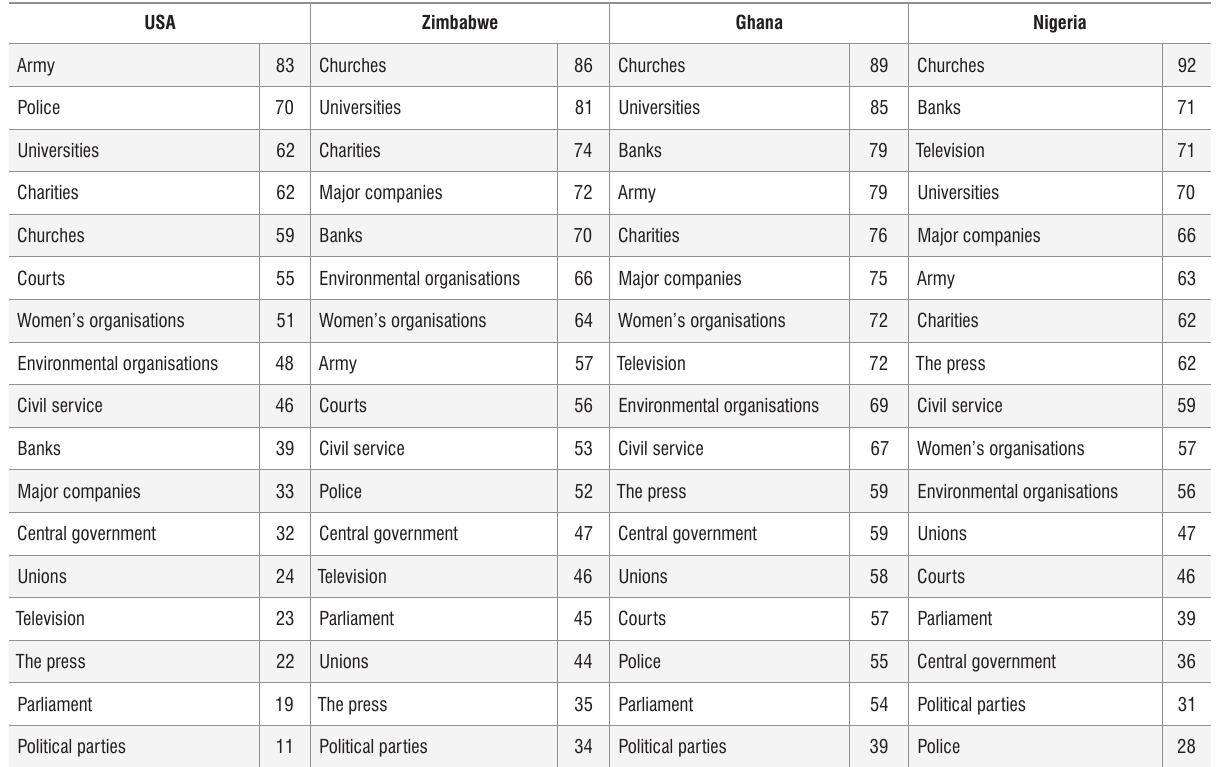
Table 1: Confidence levels ranking (%): ‘A great deal’ and ‘Quite a